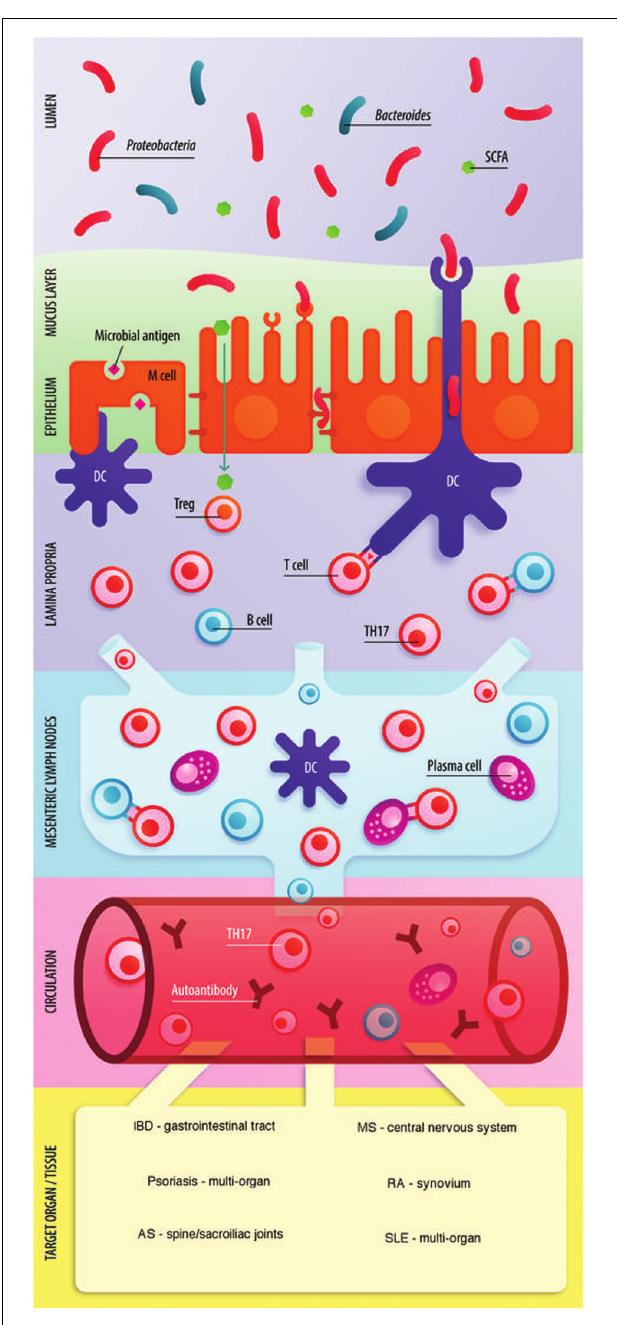
FIGURE 1 | Role of the gut microbiome in the pathogenesis of IMID. Enterocytes (via recognition of microbe-associated molecular patterns by Toll-like receptors) and M cells (transcytosis) communicate microbial dysbiosis to the mucosal immune system. Gut dysbiosis, in combination with a reduction of SCFA can shift the Treg-Th17 balance toward inflammation through Th17 expansion. Several pro-inflammatory cytokines are released in the lamina propria (LP) including IL-6, IL-17, IL-21, IL-23, and IFN- γ . The inflammatory state enhances intestinal permeability through expression of tight junction proteins including occludins and claudins and may lead to microbial translocation and enhanced antigen exposure in the LP. Activated T cells, B cells and dendritic cells (DC) travel to the mesenteric lymph nodes (MLN) via